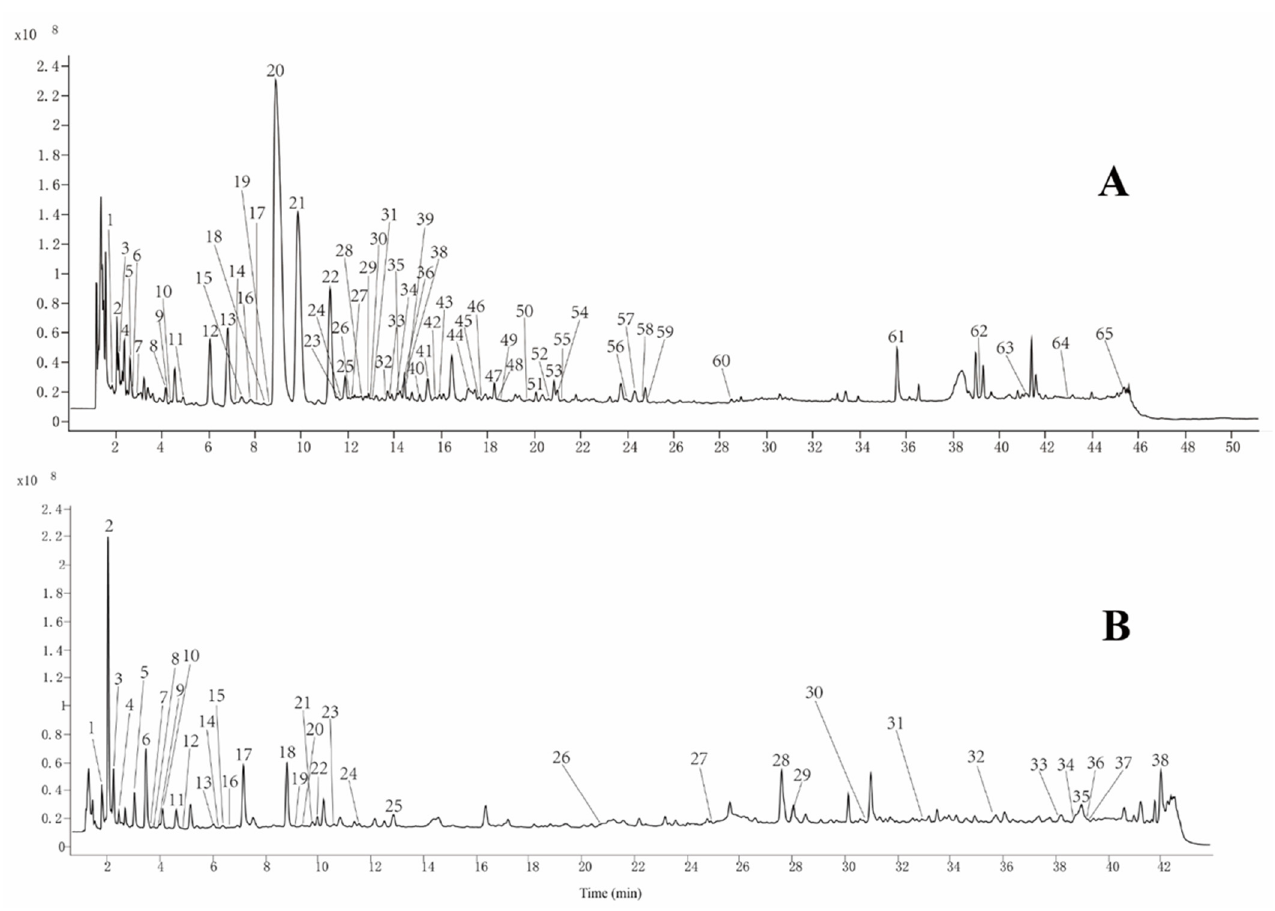
Figure 1. Total ion flow diagram of REH and HEH methanolic extracts obtained by HPLC-Q-TOF MS in positive ion mode. ( A ) fraction P1; ( B ) fraction P2.